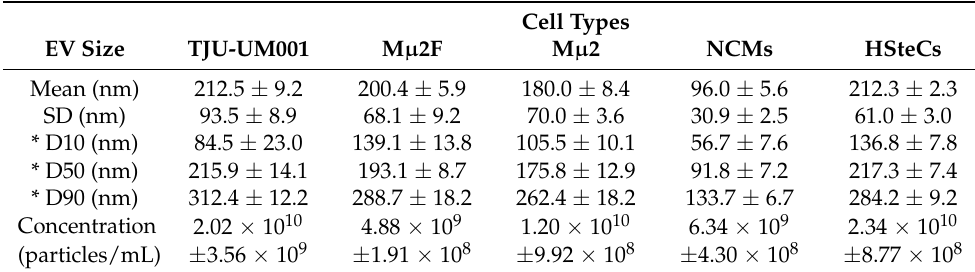
Table 1. EV size distribution and concentration determined by NTA. EVs from metastatic (TJU- UM001, M µ 2F), non-metastatic (M µ 2), and healthy cells (NCM, HSteCs) were isolated and analyzed for size (nm) and concentration